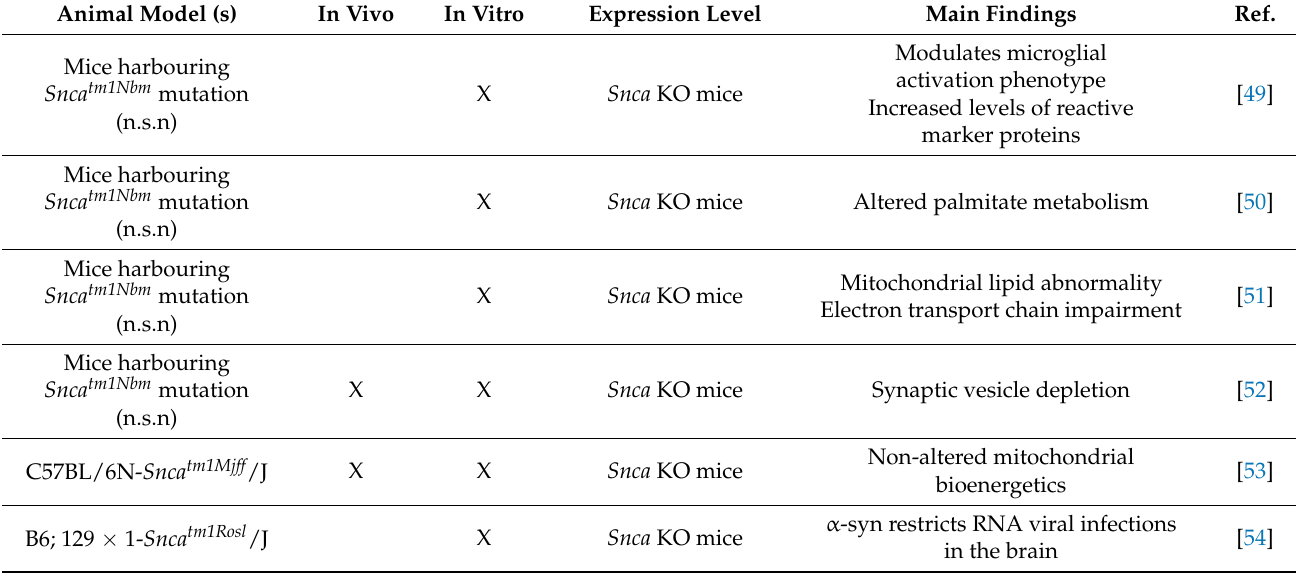
Table 3. Findings in animal models related to Snca